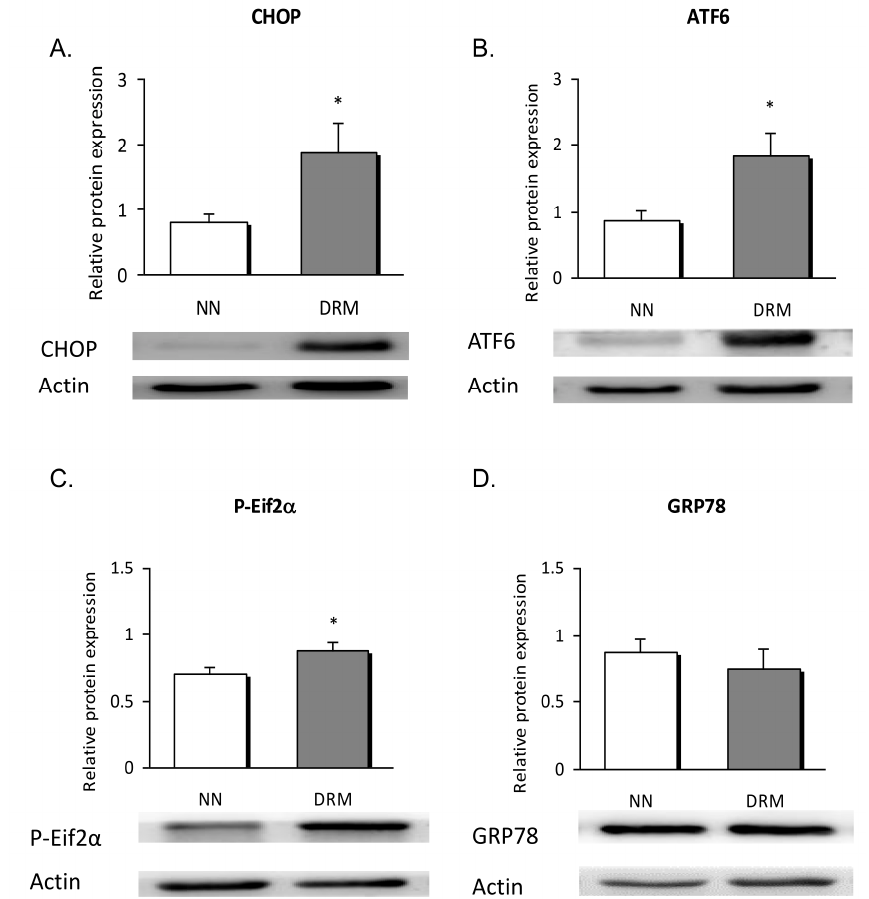
Figure 3. Leukocyte expression of ER stress proteins in NN and DRM subjects. ( A ) CHOP protein expression relative to actin protein expression, in NN vs DRM patients. ( B ) ATF6 protein expression relative to actin protein expression in NN vs DRM patients. ( C ) P-Eif2 α protein expression relative to actin protein expression in NN vs DRM patients. ( D ) GRP78 protein expression relative to actin protein expression in NN vs DRM patients. * p < 0.05 vs. NN group using an unpaired t -test NN: Normonutrition; DRM: Disease-related malnutrition; ER: endoplasmic